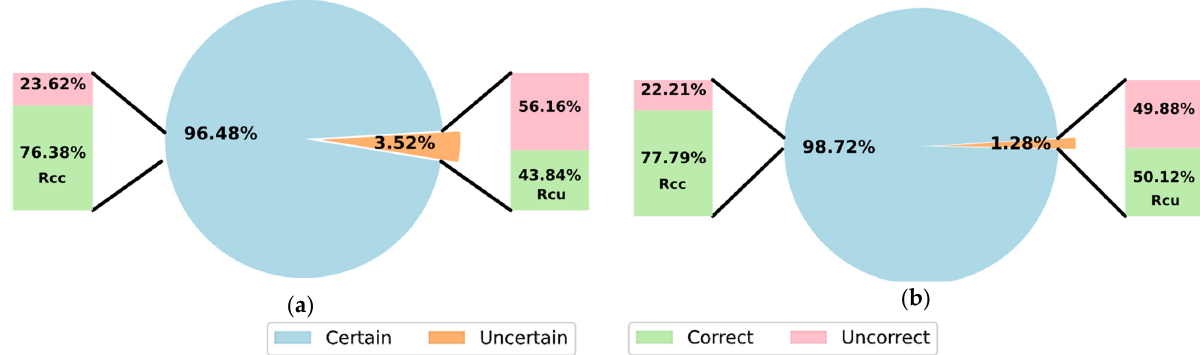
Figure 4. Results using SCNN-MOPED with the adaptive threshold scheme for MI classification with reject option, considering the subject-specific strategy, ( a ) dataset 2a; ( b ) dataset 2b.